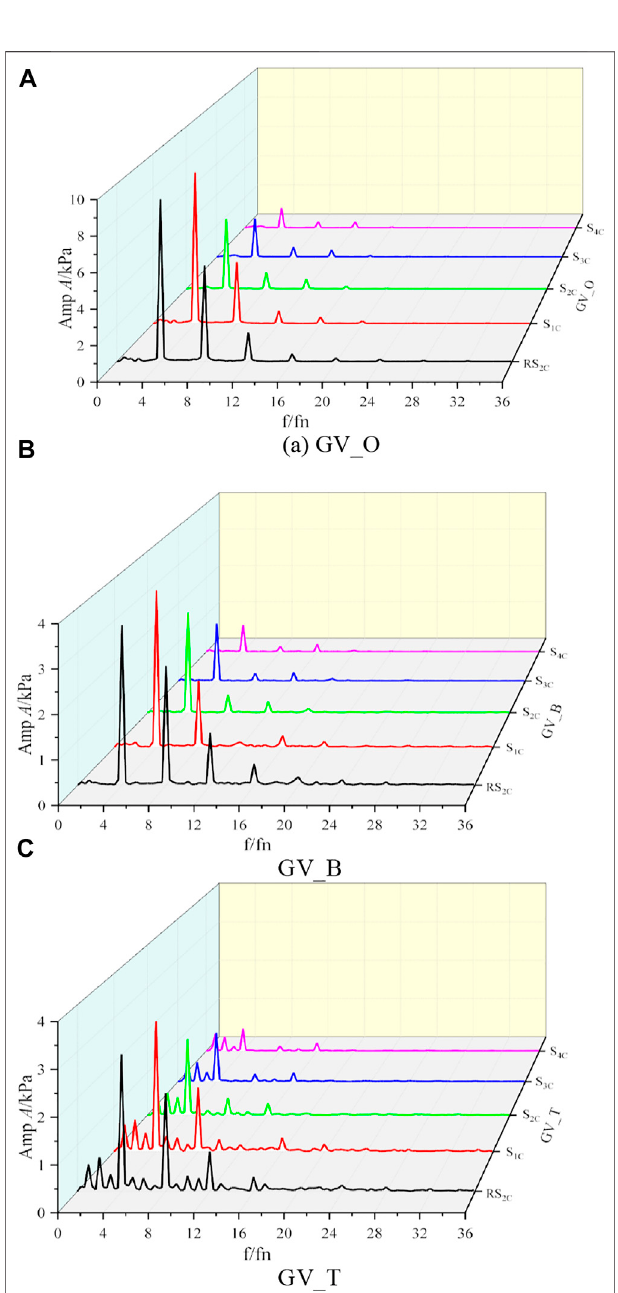
FIGURE 18 | Frequency-domain characteristics of points in guide vane. (A) GV_O. (B) GV_B. (C) GV_T.